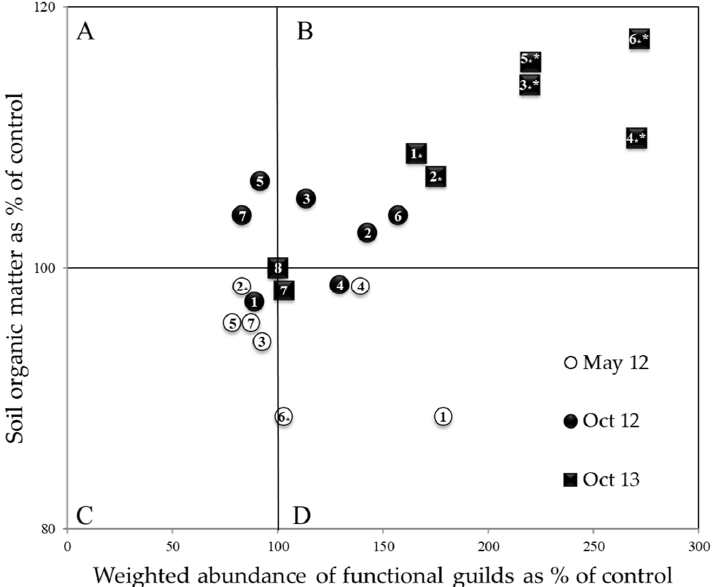
* Means with different lower case letters in rows and different upper case letters within columns indicate significant difference at p < 0.05 using Fisher’s LSD. † Data in this table are the independent variable ( x -axis) shown on Figures 3–6. NA = Not available because data are expressed as percent of the respective controls.